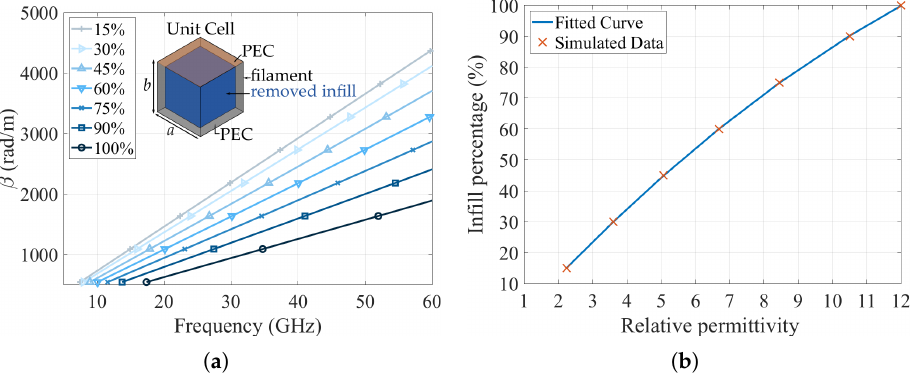
Figure 5. Unit cell analysis for different infill percentage values. ( a ) Dispersion diagram as a function of the infill percentage for ABS1200 filament. ( b ) Corresponding permittivity value as a function of the infill percentage for the ABS1200